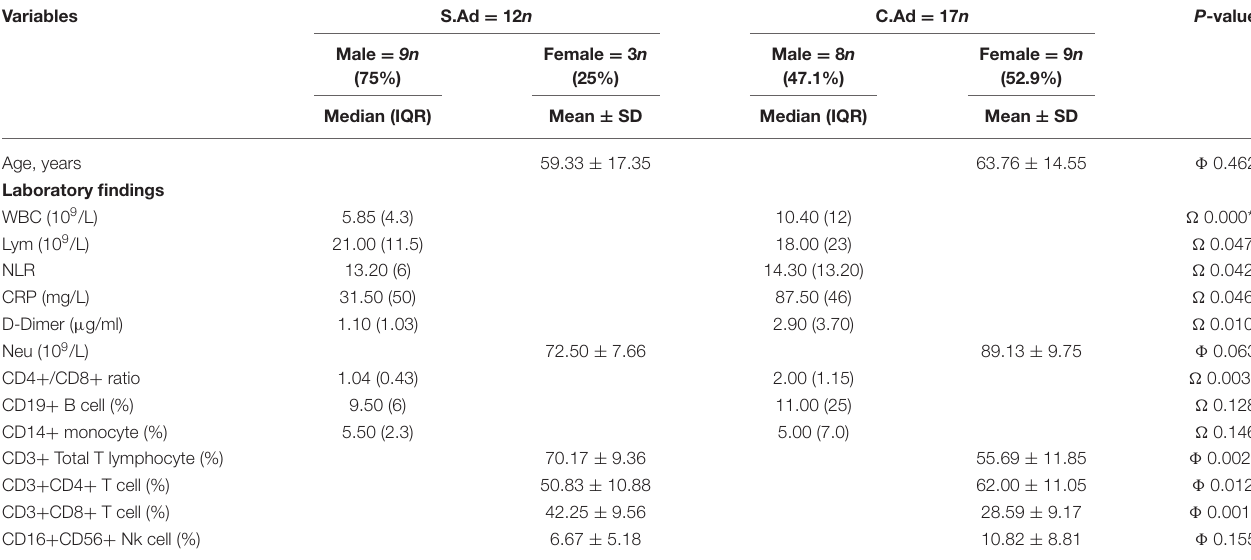
TABLE 2 | Comparison of peripheral variables of the severe adult with critical adult patients. Variables